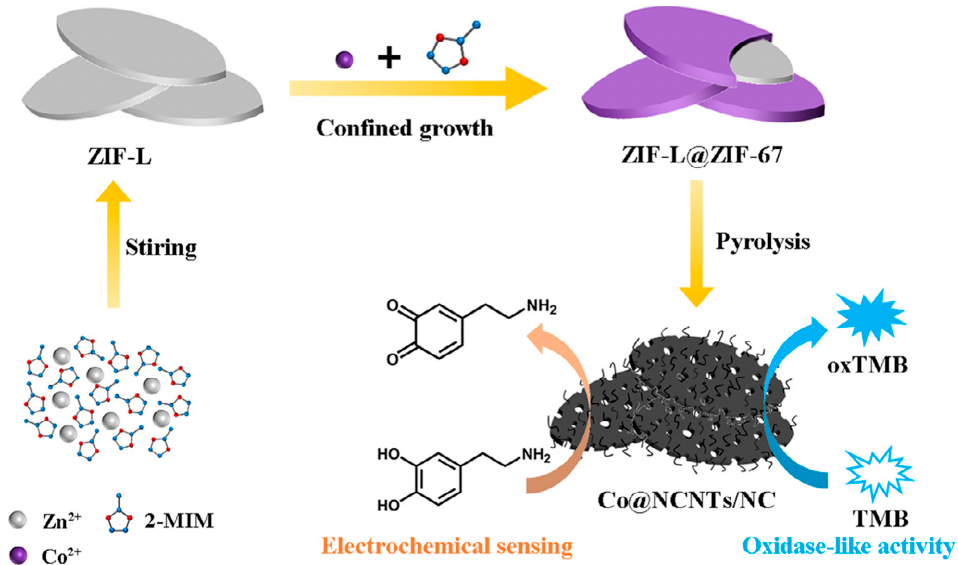
Figure 19. The schematic of the synthesis route of Co@NCNTs/NC and the sensing process [124]. Copyright: Elsevier B.V.